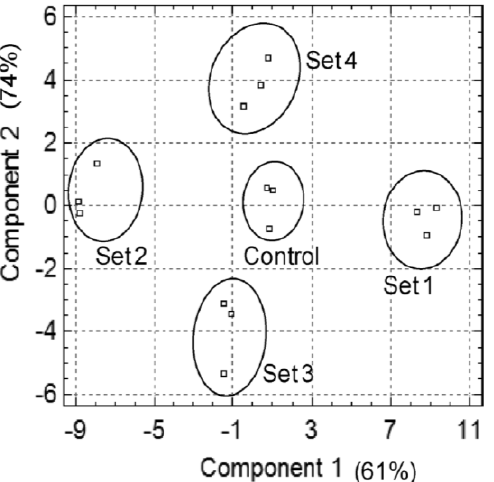
Figure 4. PCA score plot to assess the variance among the protein compositions of the four sets and the control protein mixtures ( n = 3). Component − 1 explains 62.6% of the variability of the data, whereas component 2 is responsible for 13.9% (the total accumulated percentage is 75%).